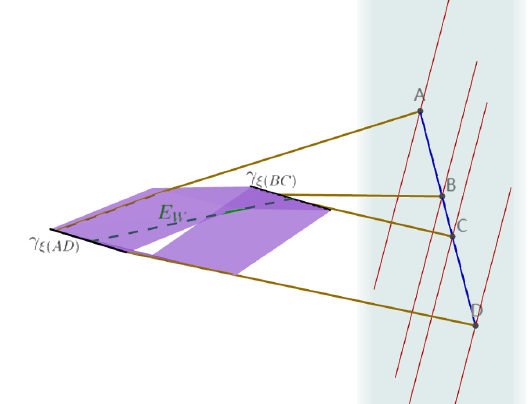
Figure 10 . The figure shows the non-trivial connected pre-entanglement wedge W ξ [ A ] and its cross section E (green) related to two disconnected (blue) boundary intervals AB and CD . It is drawn W in the planar BTZ black hole spacetime. For clarity, we choose the two intervals sitting on the same line and omit the black hole horizon. E has a U(1) translational symmetry along the v direction, W which is parallel to the infinite bifurcation horizon γ and γ . W [ A ] would never intersect ξ ξ ( BC ) ξ ( AD ) the asymptotic boundary, which is a new phenomena in AdS 3